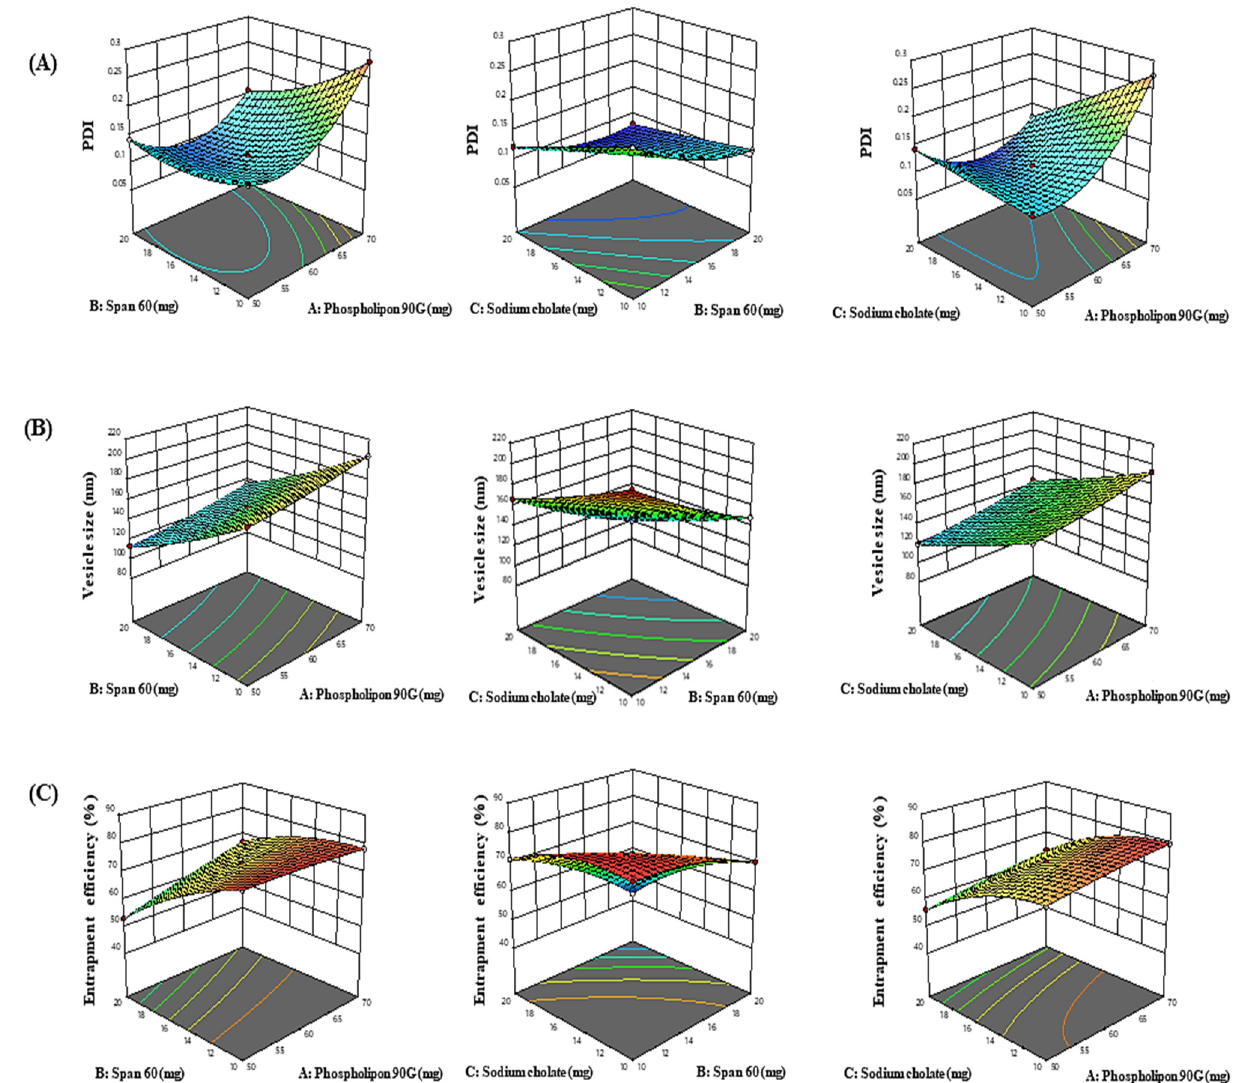
Figure 1. 3D-response graphs representing the effect of independent variables on ( A ) PDI, ( B ) vesicle size, and ( C ) entrapment efficiency.